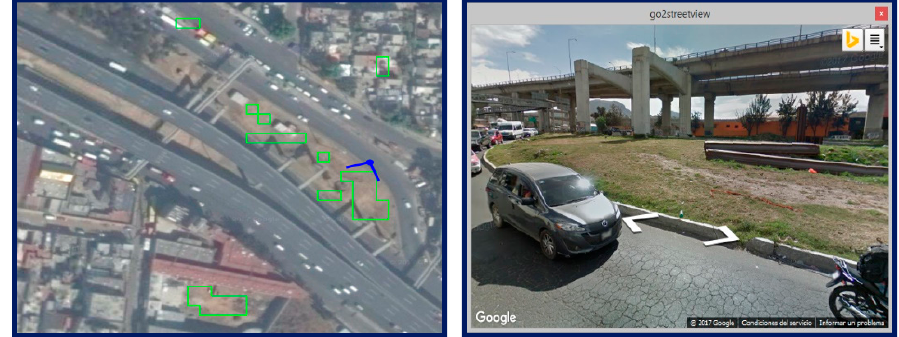
Figure 2. Training sites for bare soil (green squares on the left) located at I. Zaragoza Avenue in the Iztapalapa borough of Mexico City.